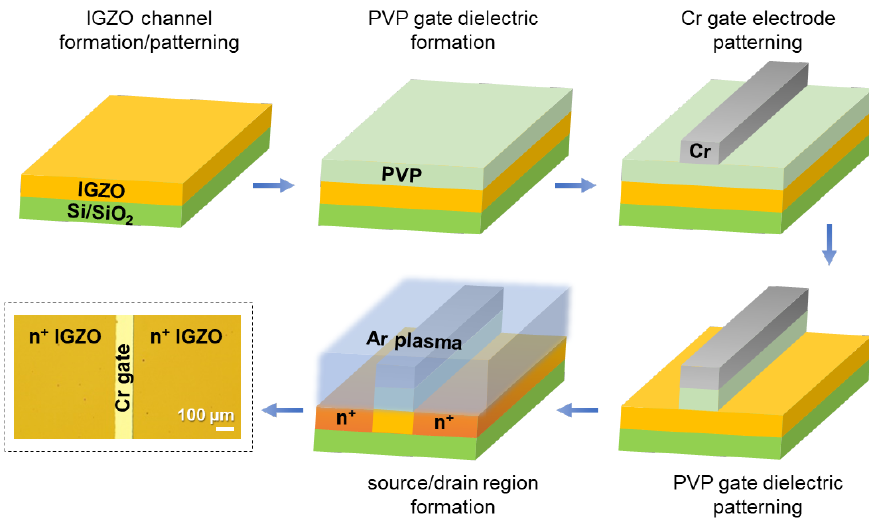
Figure 1. Fabrication process, schematic device structure and an optical image of self-aligned top-gate indium-gallium-zinc-oxide (IGZO) thin-film transistors (TFTs). The deposition of IGZO channel and poly(4-vinylphenol) (PVP) gate dielectric layers was carried out by using a solution process. The Ar plasma treatment was utilized to form the low-resistance S/D contact regions.